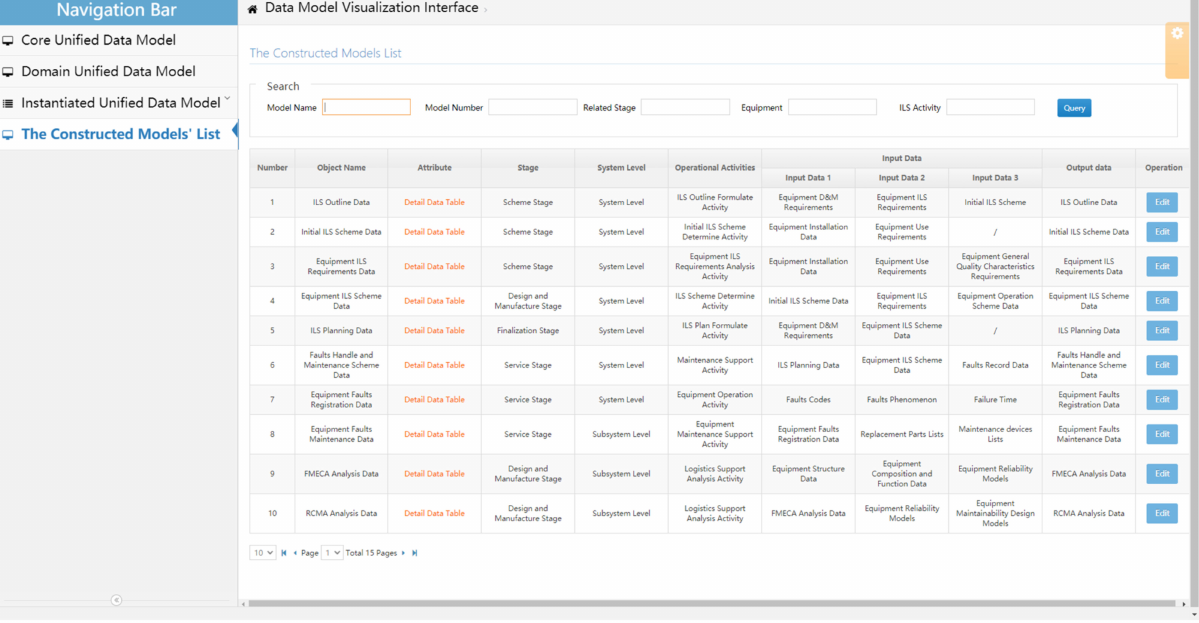
Figure 17. Information retrieval and display of the constructed Instantiated unified data